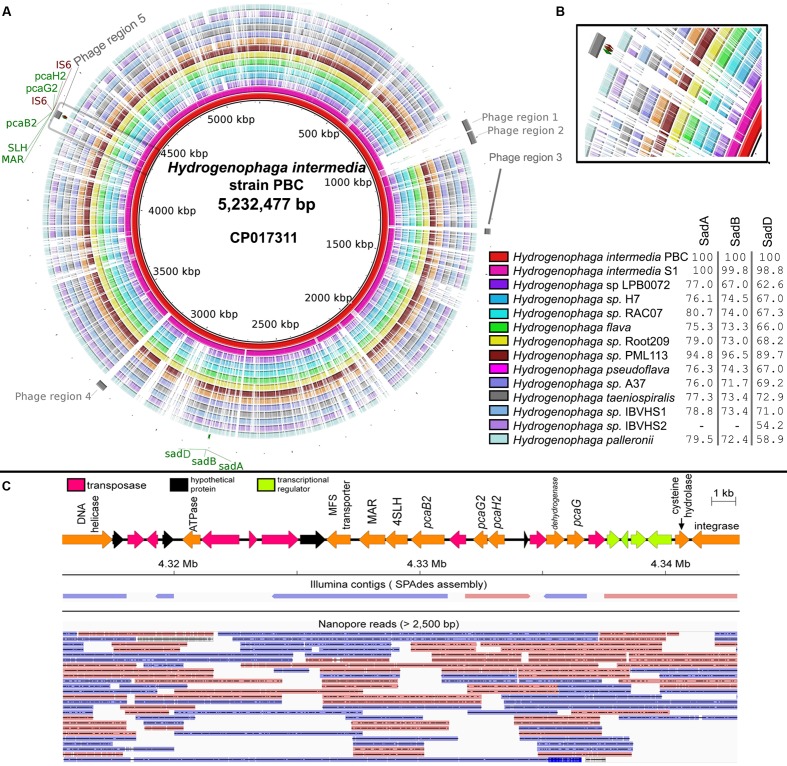
(A) Circular genome visualization of Hydrogenophaga intermedia PBC and genomic comparison with 13 additional Hydrogenophaga strains. Colored regions indicate region with nucleotide similarity (E-value < 1e-10) and percentage values next to figure legend indicate protein identity to SadA (WP_009515254.1), SadB (WP_009515256.1), and SadD (WP_009515258.1) of H. intermedia PBC that are involved in the deamination of 4-aminobenzenesulfonate (Gan et al., 2012c). Gray areas located at the most external ring indicate putative prophage regions. Maroon labels indicate genes coding for transposase element. pcaG2, protocatechuate dioxygenase type II alpha subunit; pcaH2, protocatechuate dioxygenase type II beta subunit; SLH, 4-sulfomuconolactone hydrolase; MAR, maleylacetate reductase; sadA, 4-aminobenzenesulfonate 3,4-dioxygenase; sadB, glutamine synthetase; sadC, ferredoxin; IS6, transposase. (B) Genomic regions containing genes associated with 4-sulfocatechol biodegradation (gray box). (C) Mapping of Illumina contigs and Nanopore long reads onto the genomic region containing the genes involved in 4-sulfocatechol metabolism. Blue and red arrows indicate forward and reverse strands respectively.